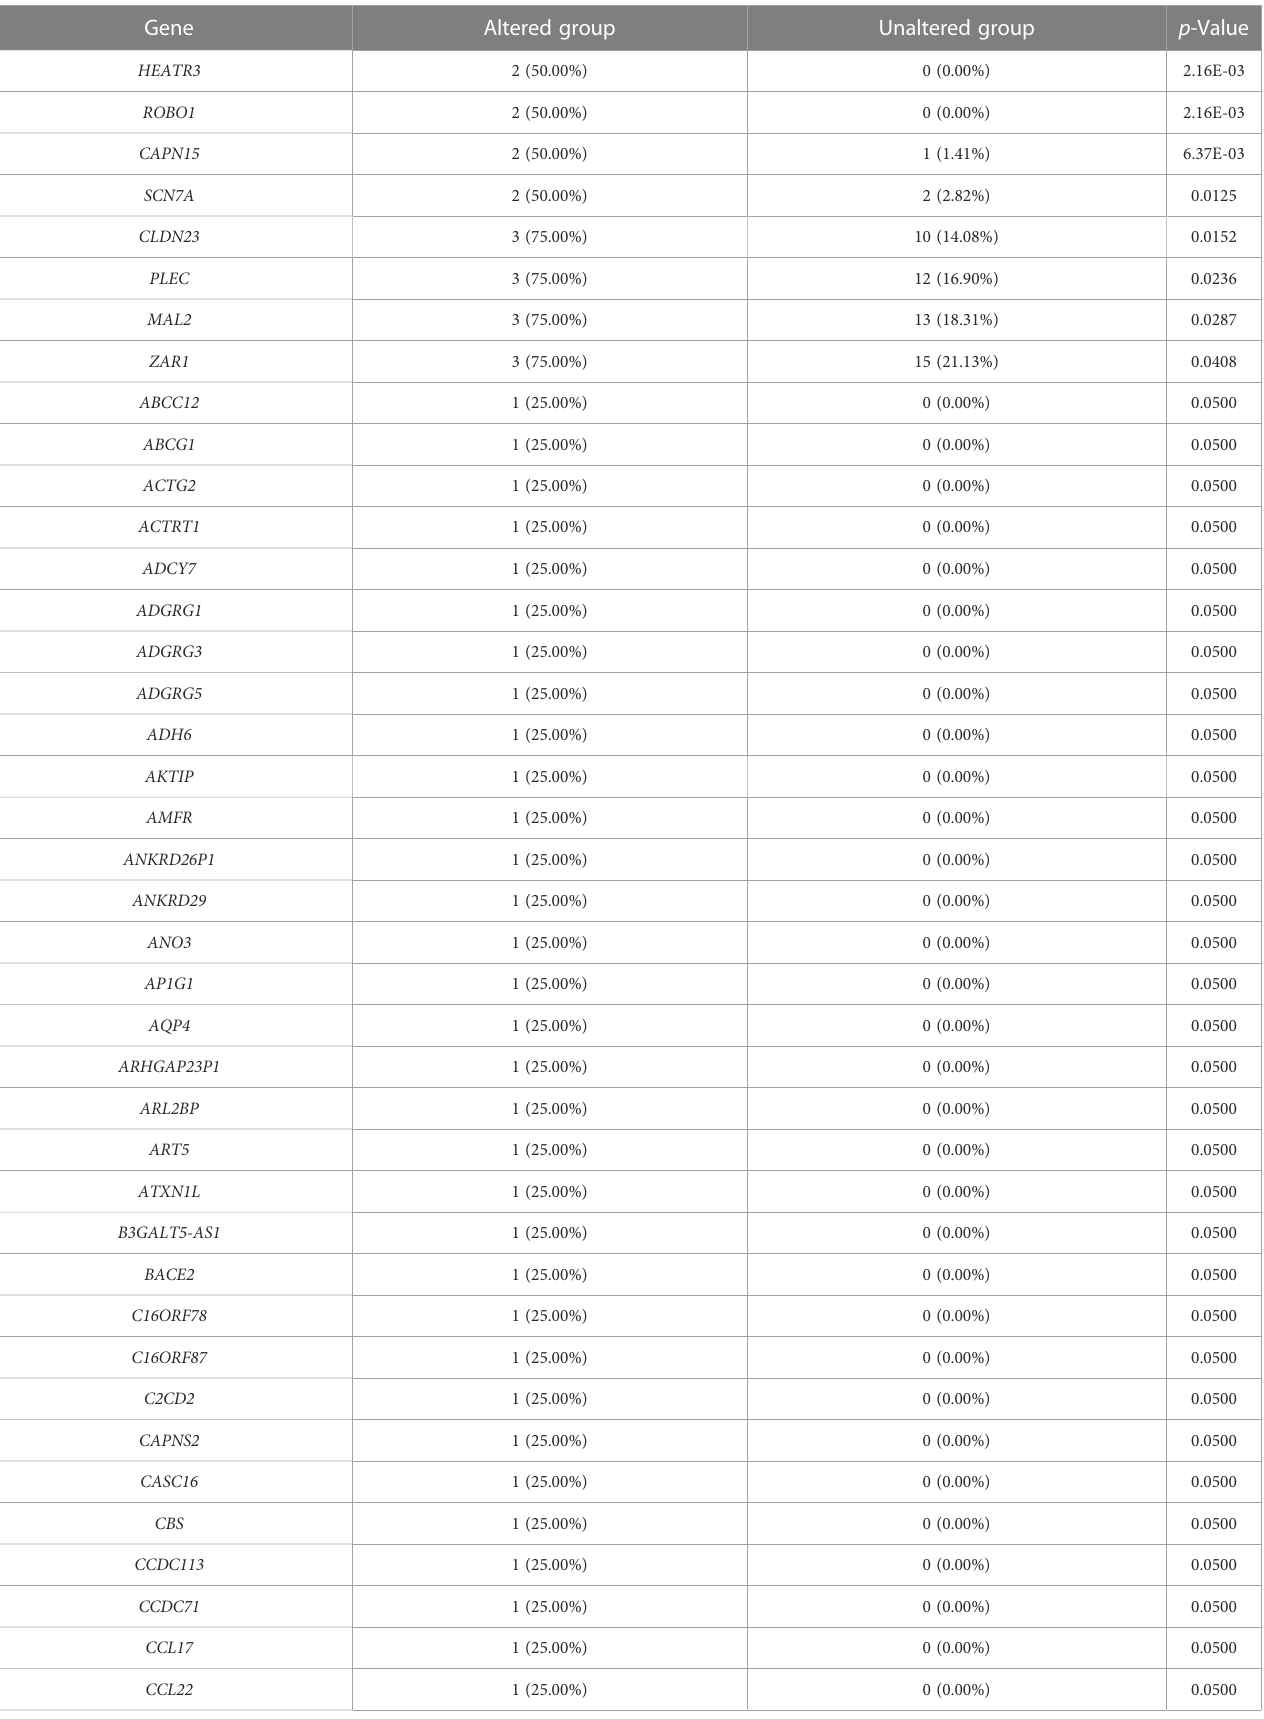
TABLE 1 The top 50 of BRD2 neighbor gene alterations in ACC